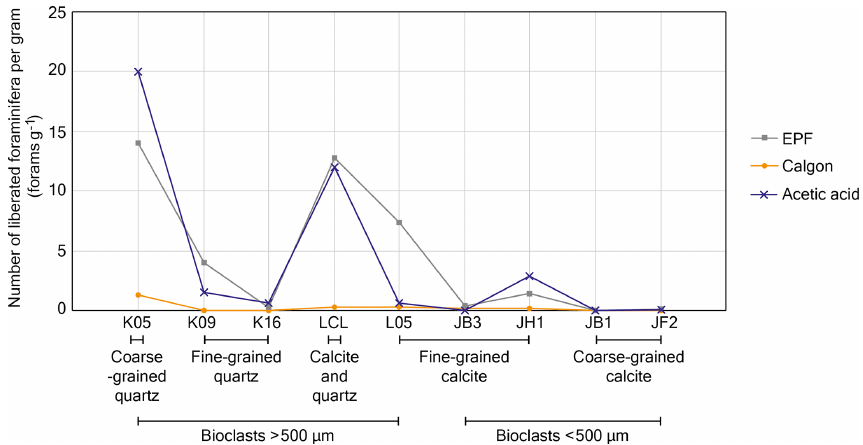
Figure 5. Number of liberated larger foraminifera per gram of each sample for each of the three methods. Samples are organised into types of infilling cements and sizes of bioclasts; further details can be found in Tables 1 and 4.